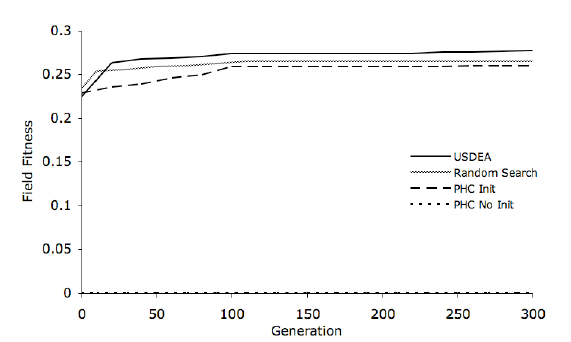
Fig.6. Benchmarking for a Mesh Field with an MCSS of 4